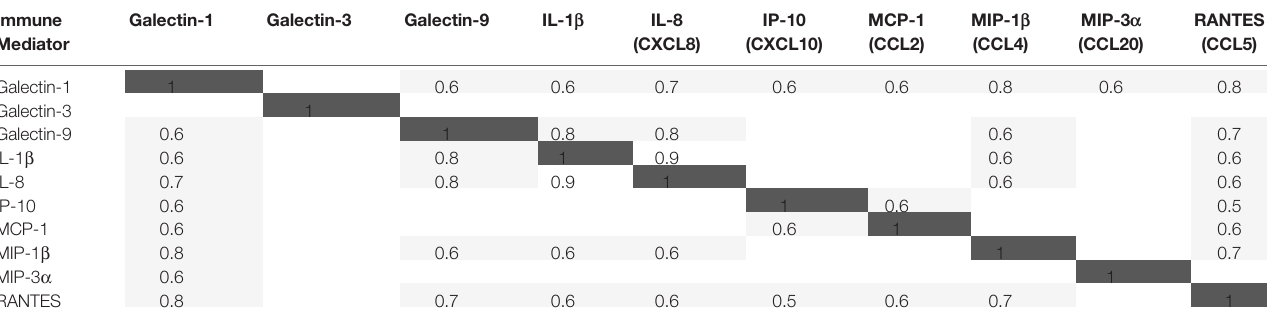
TABLE 2 | Pearson correlation between cervicovaginal levels of immune mediators in all 446 visits. Immune